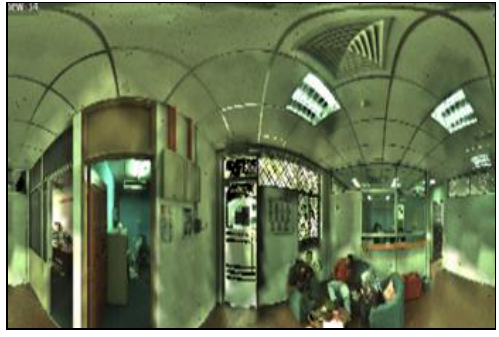
Figure 6. Scanned data of one area The flow of methodology for GeoSlam Zeb-Revo as shown in Figure 7. All these flows were discussed in following points.